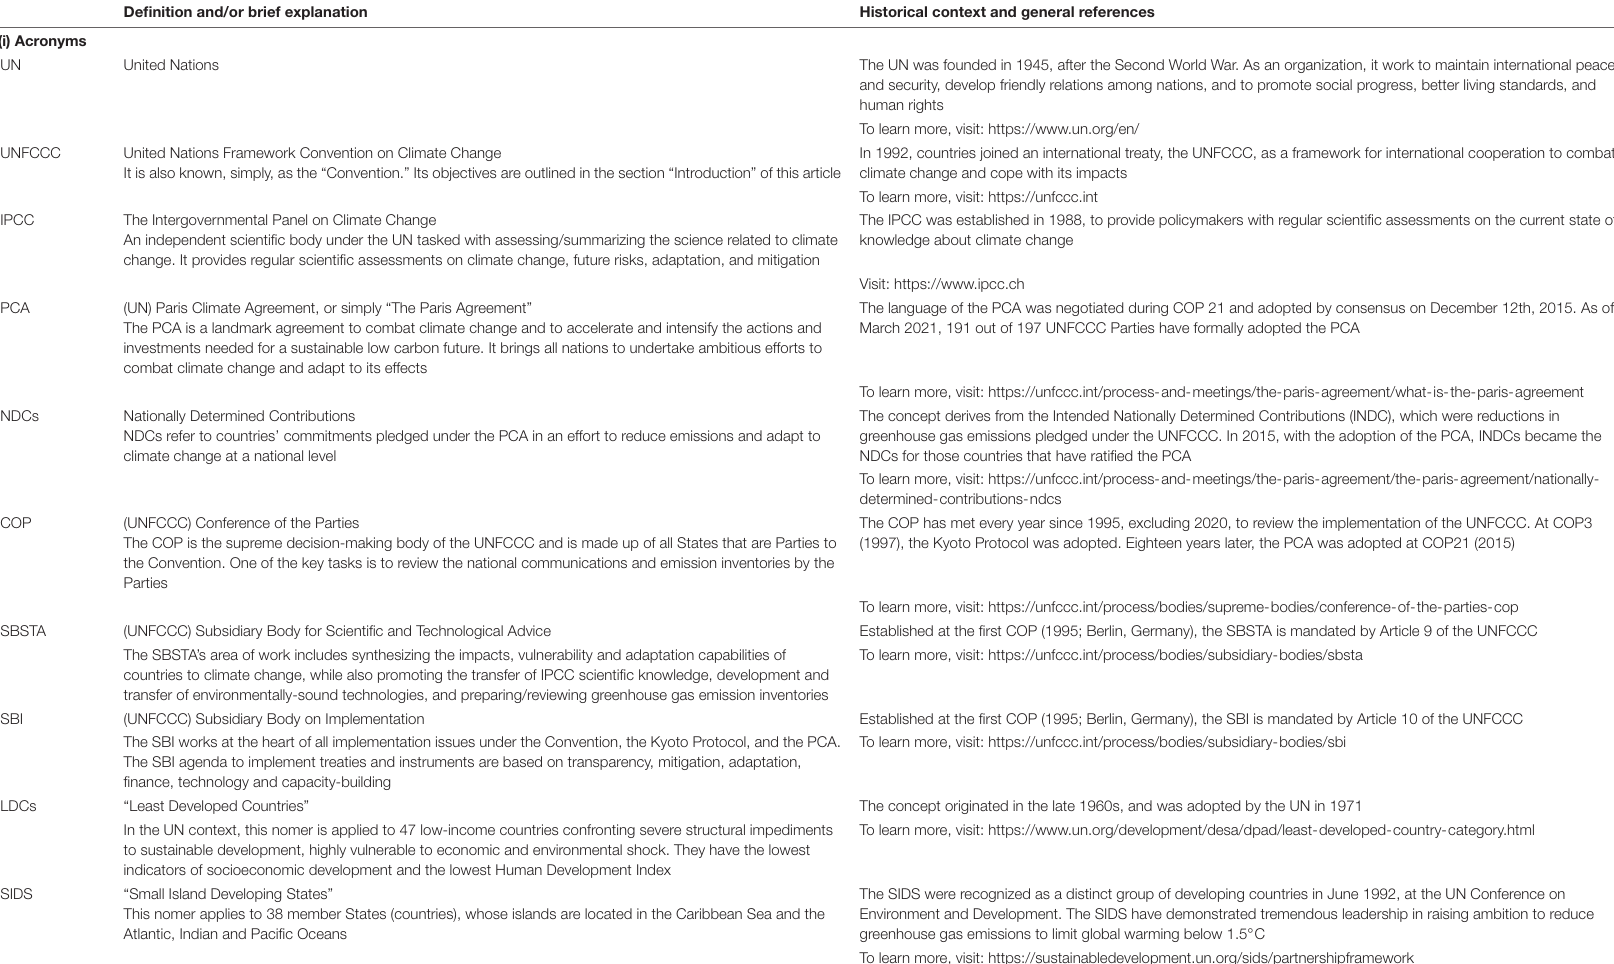
TABLE 1 | Definitions and reference materials for (i) Acronyms, (ii) Participants, (iii) Key terms, (iv) Relevant texts and entities invoked throughout the text. Definition and/or brief